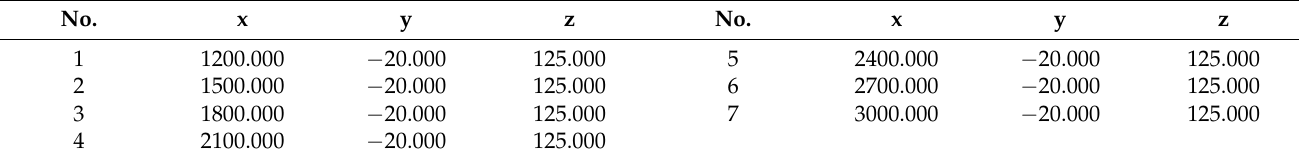
Table 4. The coordinates of the centers of mass of the soybean particle